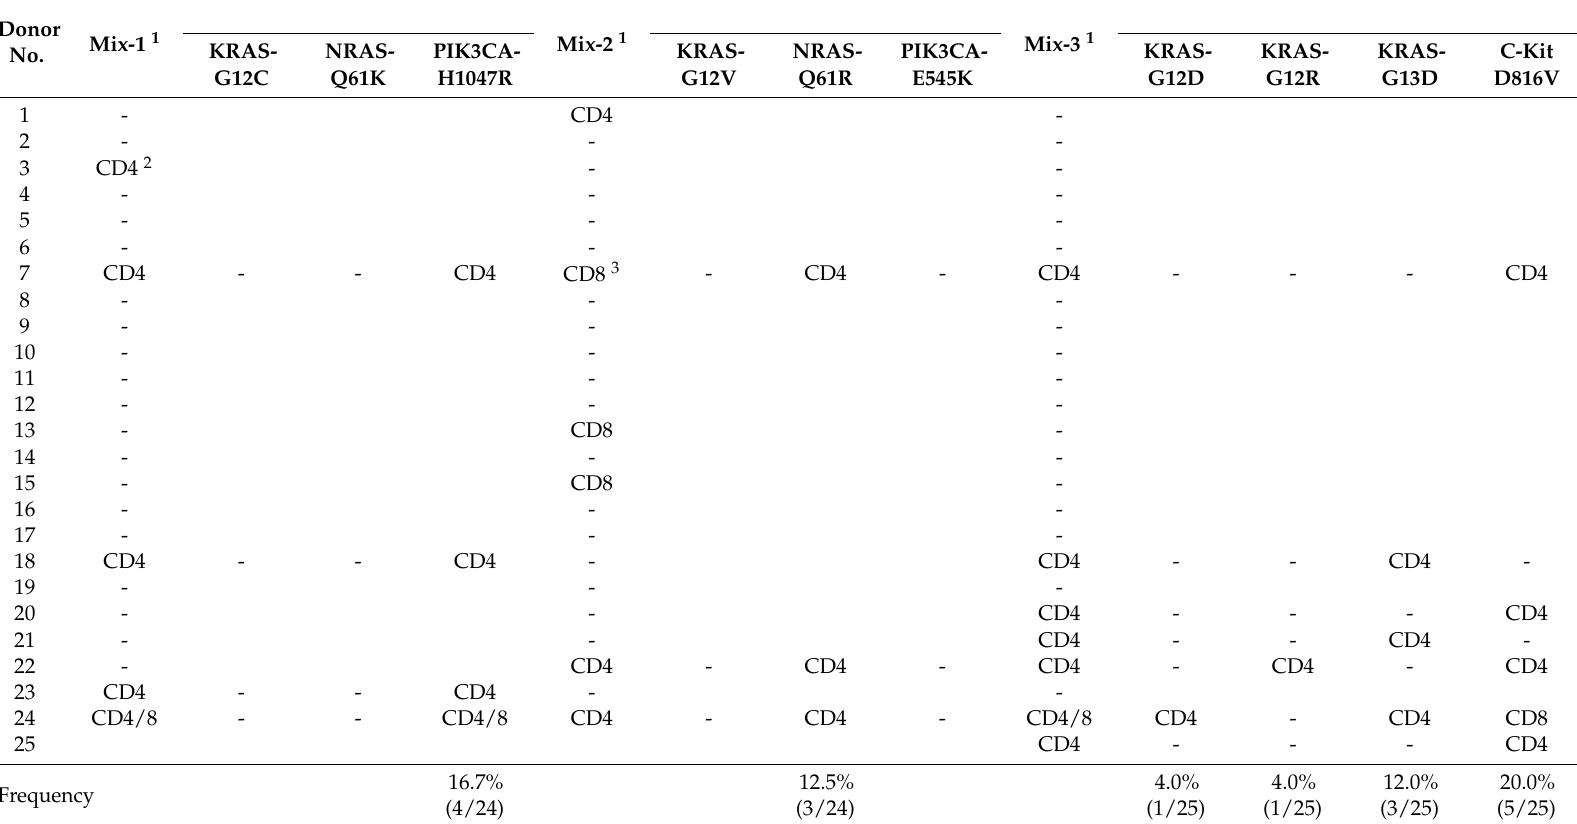
Table 2. Summary of immunogenicity of the synthetic peptides derived from driver